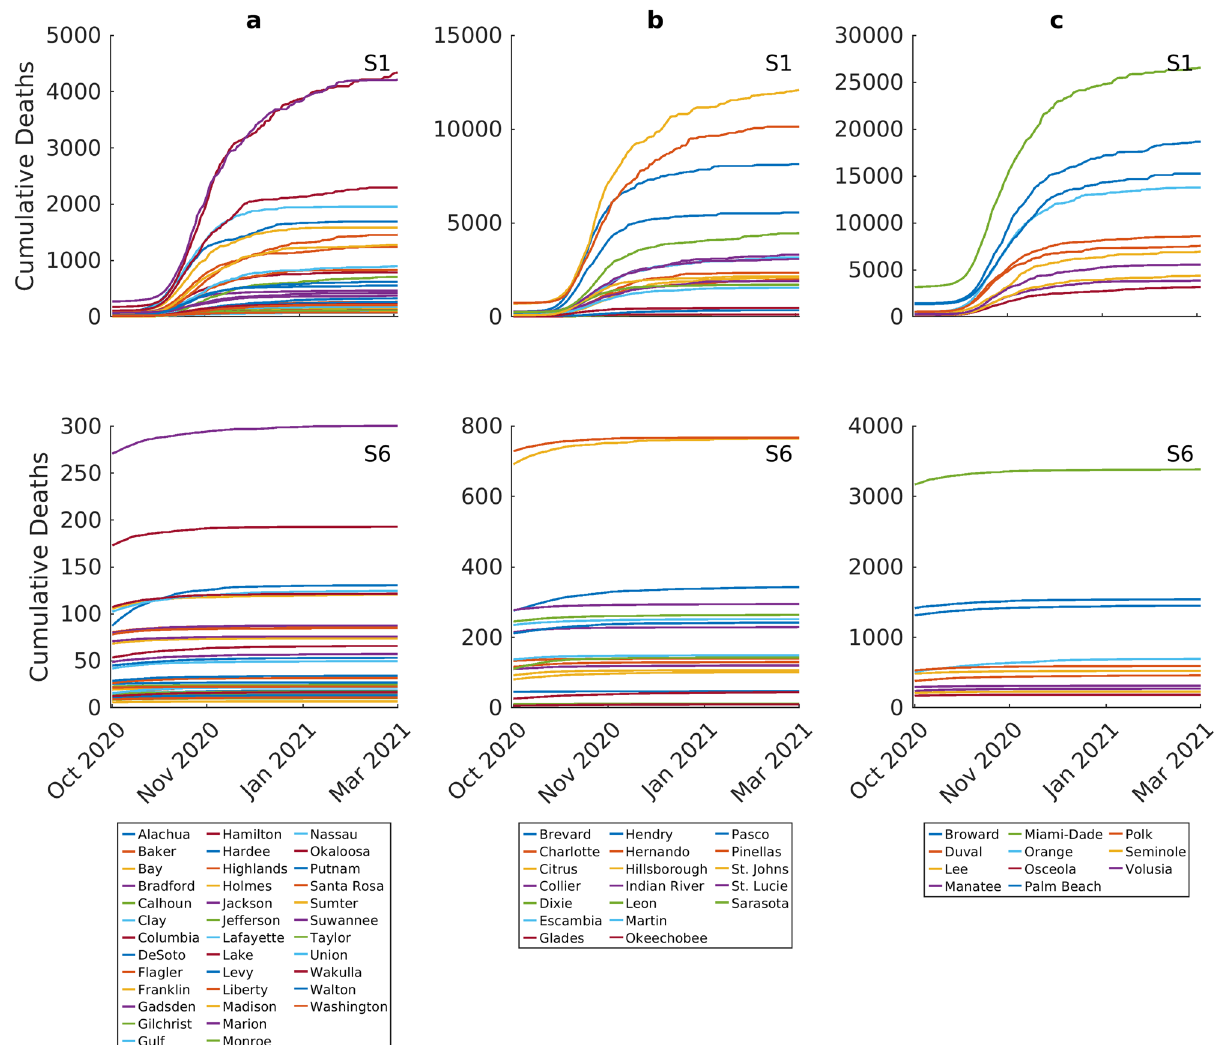
Figure 7. Cumulative number of deaths predicted over time for Scenario 1 (full release of interventions on October 1st) and Scenario 6 (lockdown, social distancing, and quarantining through March 2021). Each curve represents the median prediction for a given county. The results are stratified by initial incidence growth rate in each county (Group a < 0.05, Group b > 0.05–0.15, Group c >